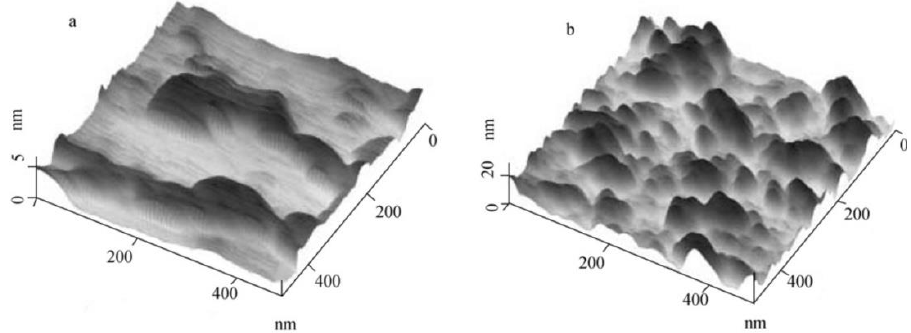
Figure 6. AFM morphological images of TiO 2 films deposited at ( a ) 0.4 Pa and ( b ) 1.4 Pa. Reprinted with permission from [93], copyrught 2009, Elsevier.